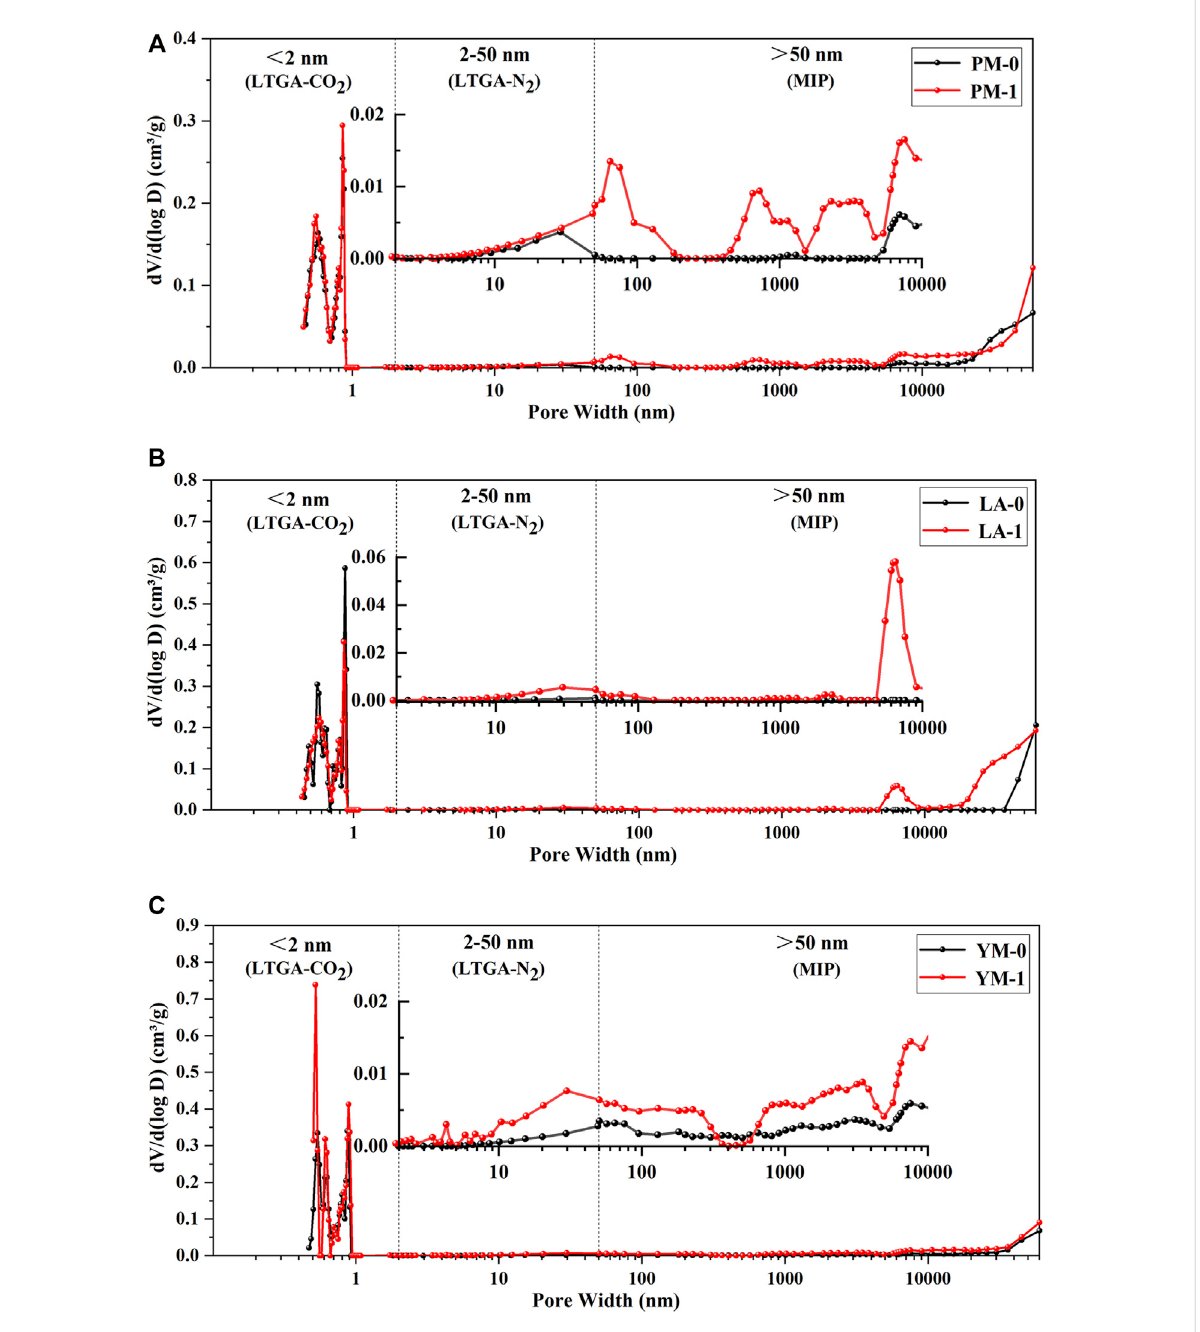
FIGURE 7 Full-sizedporevolumedistributioncurvesoftherawandacidi fi edcoalsamples,andtheinsertswerethepartialenlargementcurves: (A) PM; (B) LA; (C)